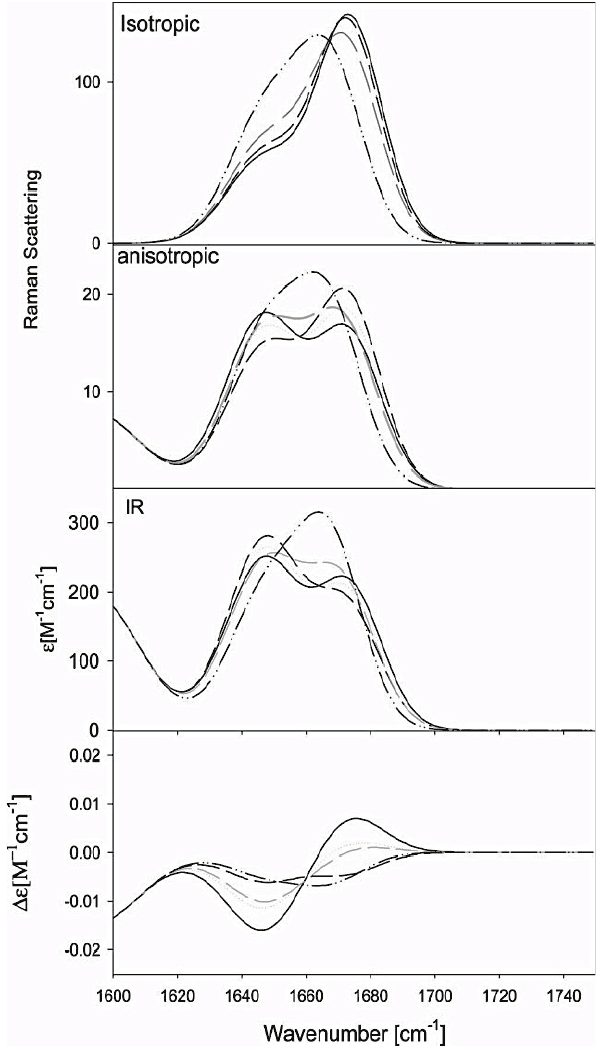
dirchroism (VCD) amide I profiles of tripeptides simulated for different conformational ensembles, i.e. , 100% pPII (solid line), 100% (cid:8)-strand (dashed line), 50:50 mixture of pPII and (cid:8)-strand (dashed gray), and 100% right-handed helical (dashed-dot-dot). (Taken from ref. [101] with